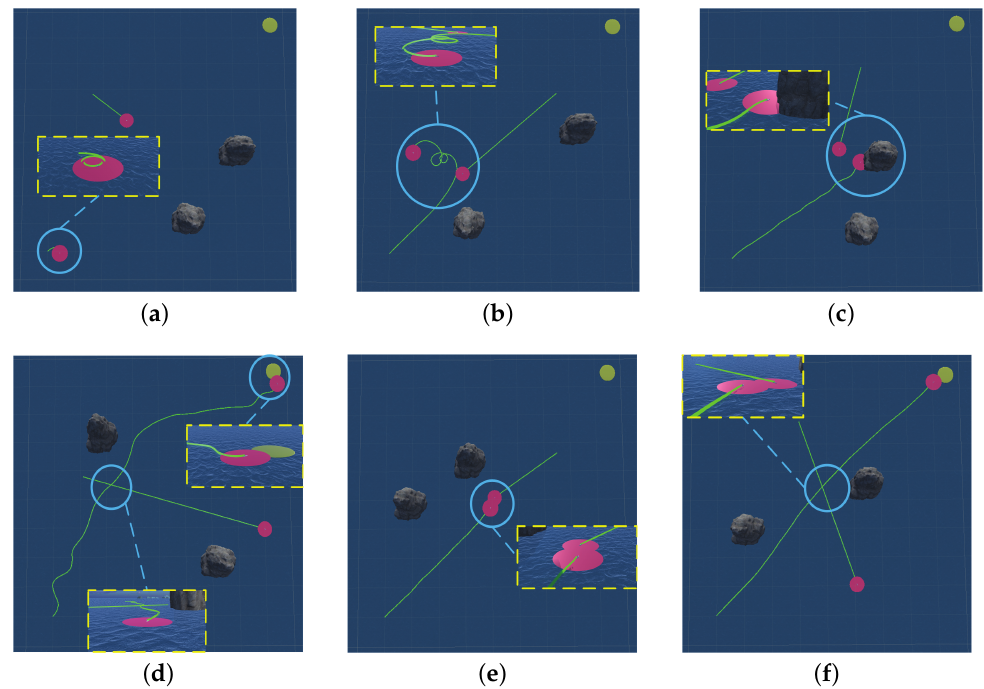
Figure 9. Training. ( a ) First episode; ( b ) 9th episode; ( c ) 20th episode; ( d ) 46th episode; ( e ) 124th episode; ( f ) 358th